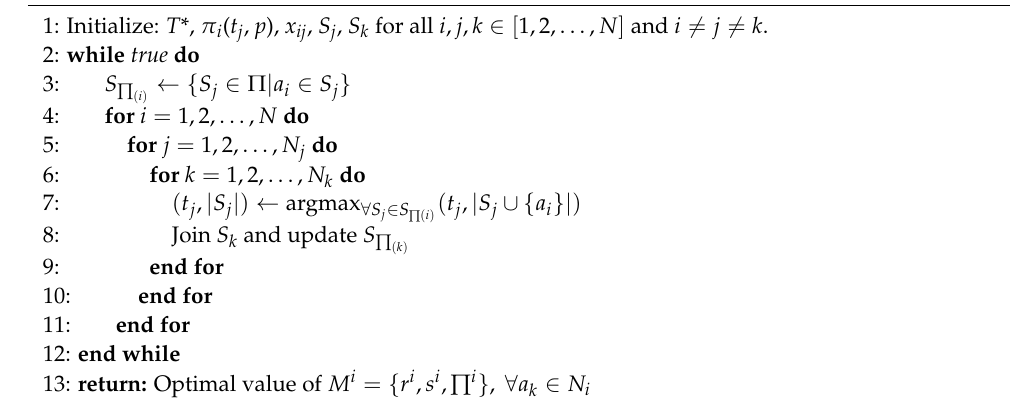
Algorithm 1: Decision-making algorithm for robot a